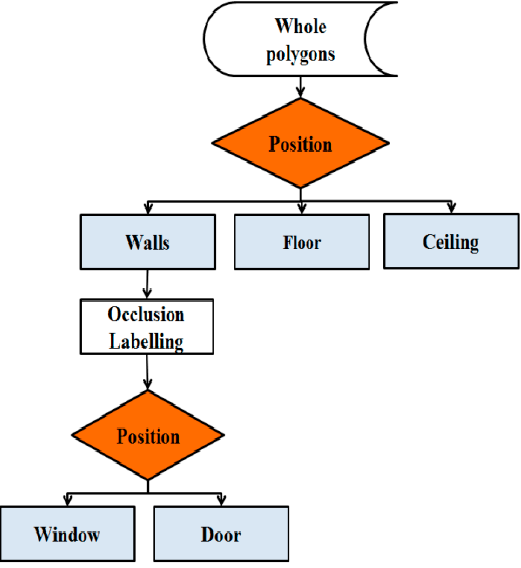
Figure 9. Hierarchical classification tree, orange diamonds are the conditions while blue rectangles represent room elements.